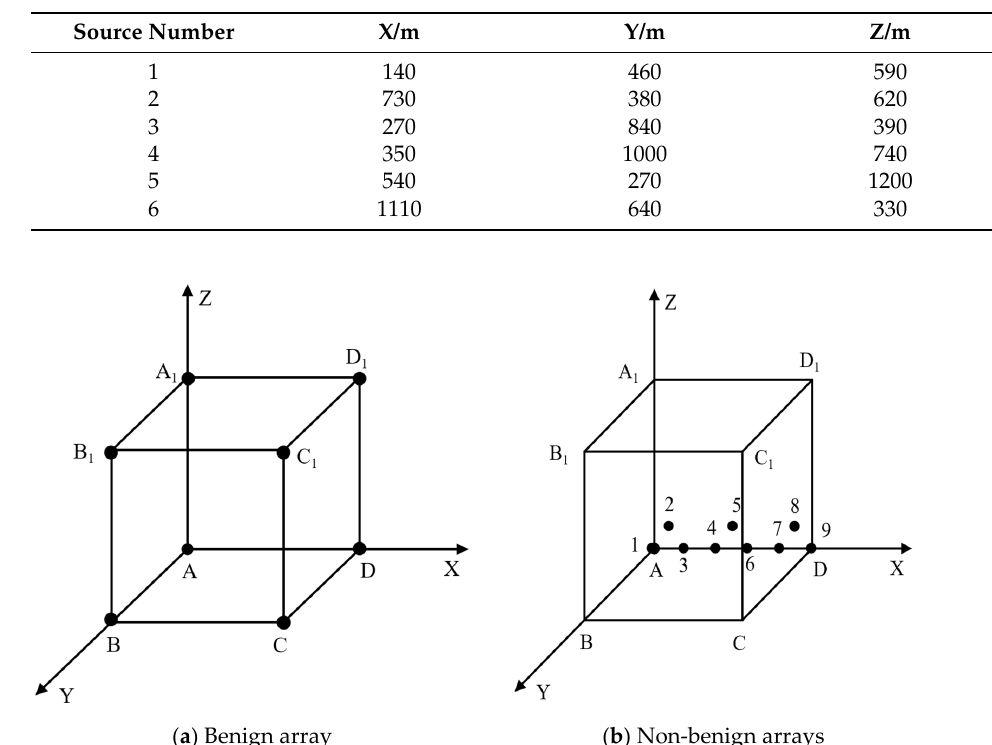
Figure 4. Schematic diagram of sensor layout array. Table 1. 3D coordinates of benign array detectors.